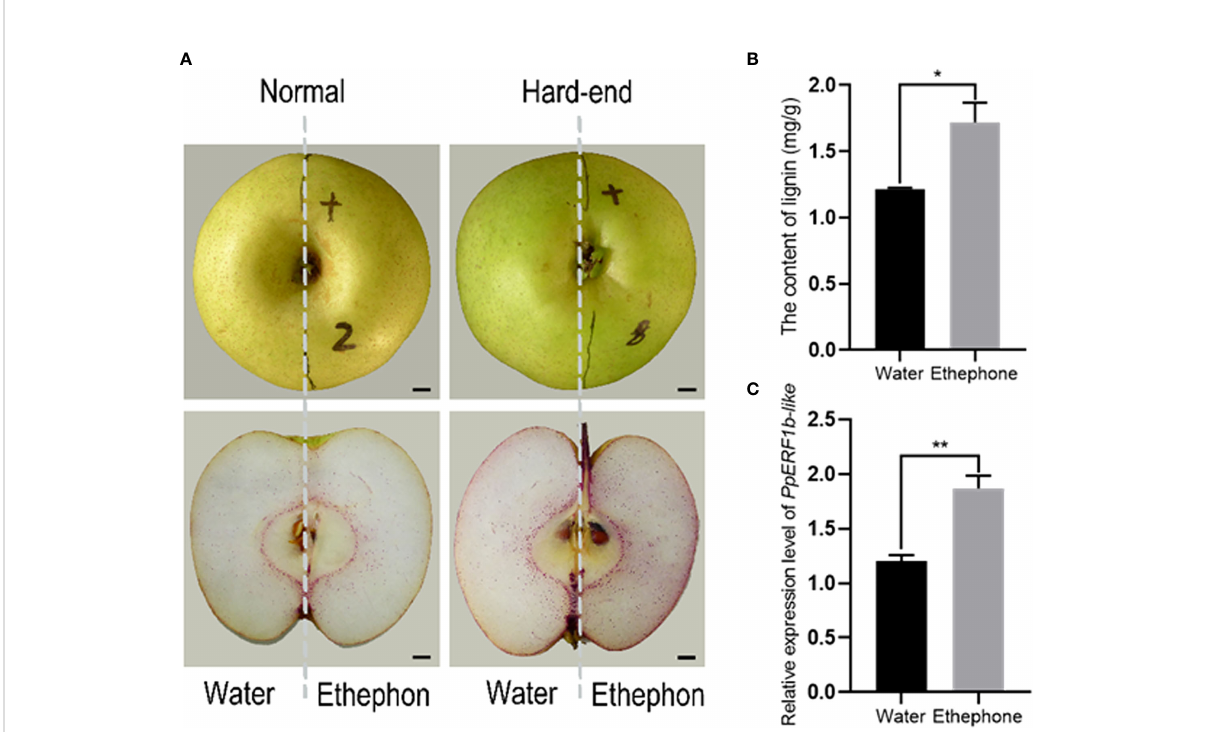
FIGURE 3 Ethephon promoted lignin accumulation and induced the expression of PpERF1b-like . (A) Half of the fruit was treated with water and the other half with ethephon. Scale bars = 100 m m. (B) , The content of lignin. (C) The relative expression level of PpERF1b-like . Data are given as mean ± SD (n = 3). The asterisk represents a signi fi cant difference (* p < 0.05; ** p < 0.01) using Student ’ s t-test